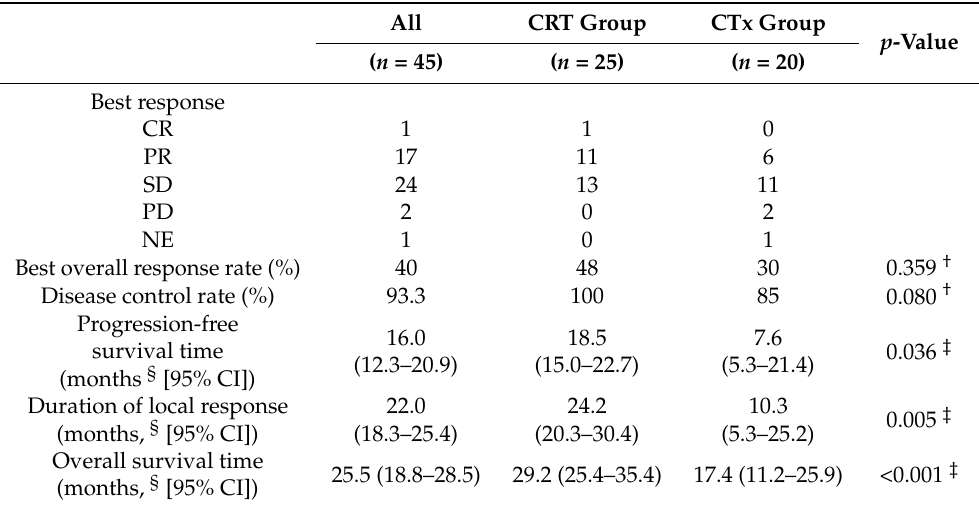
Table 2. Treatment outcomes for patients with UR-LAPC who underwent gemcitabine plus nab- paclitaxel as first-line